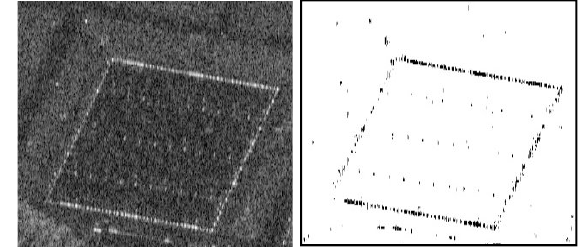
Figure 1. Example results of the coherent scatterer detection: SAR amplitude patch (left) and coherent scatterers